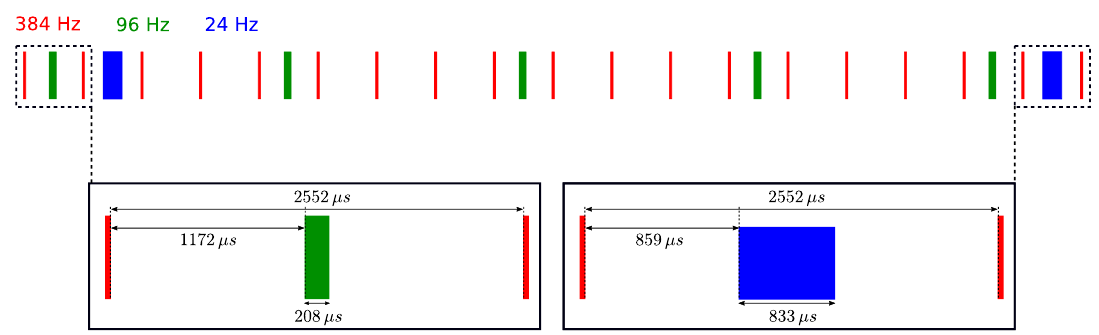
Figure 2. Pulsing scheme of the primary proton beam of HBS. Red, green and blue pulses will be sent to the di ff erent neutron target stations. The lower part of the figure shows the time between subsequent pulses.